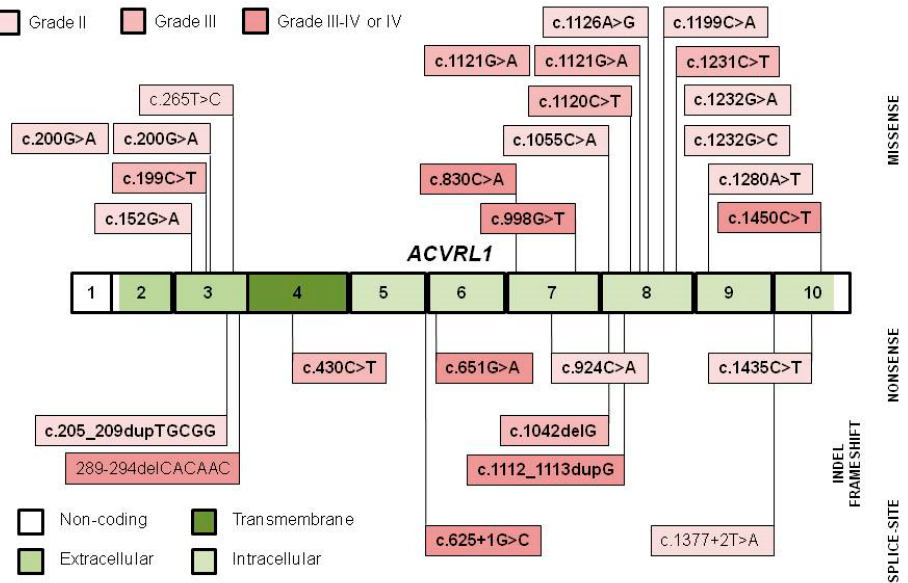
Figure 2. The grade II to IV founder variants in the exons and flanking intronic regions of ACVRL1 . Pathogenic variants are indicated in bold. In the case of the c.200G>A and the c.1121G>A variants, two distinct flanking haplotypes were identified [25].